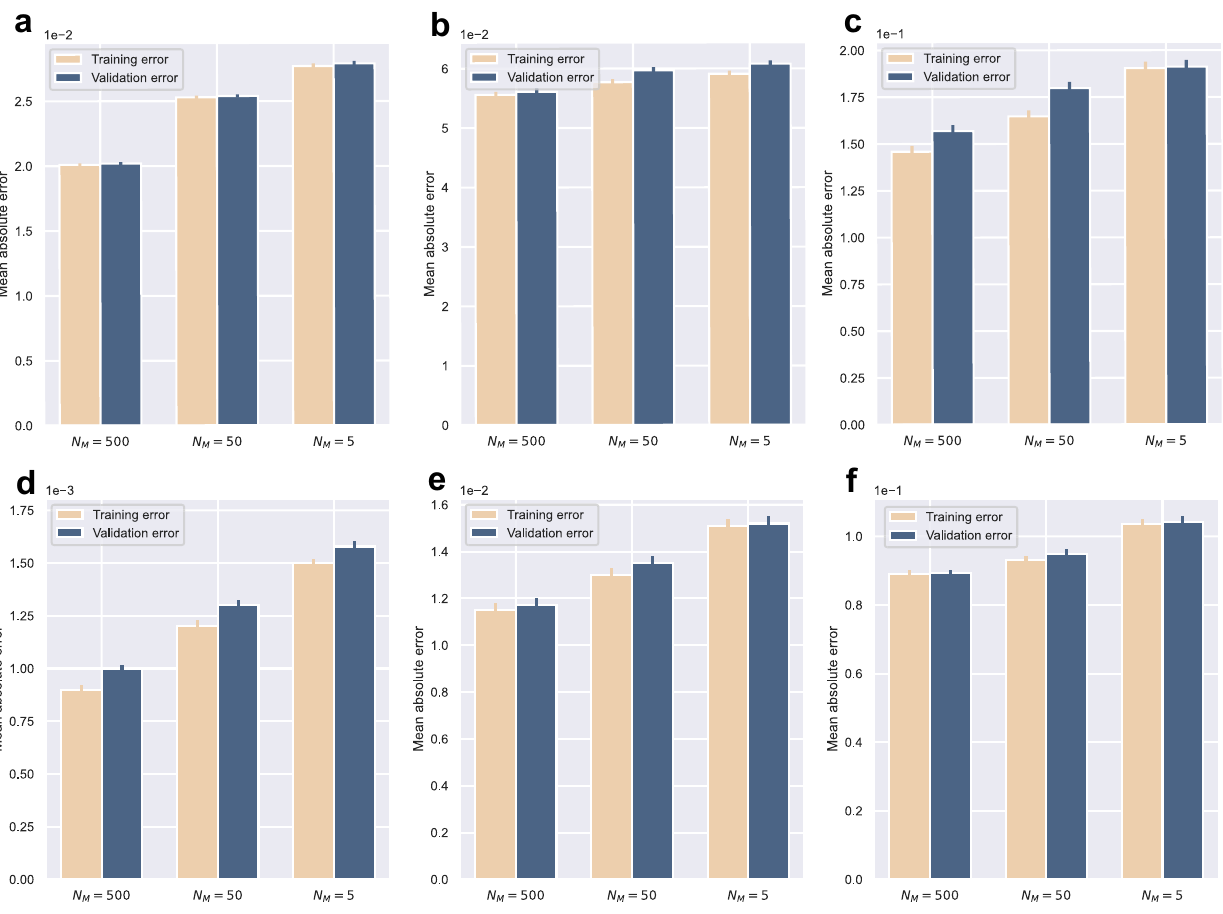
Fig. 6 The mean absolute error (MAE) of different evolution times for estimating the second-order Rényi entropy of half-partition subsystem. a – c are the training and validation MAE with N = 20, J = 1, and evolution times t = {0.5, 1, 3}, respectively. d – f are the training and validation MAE with N = 30, J ~ U (0, 1], and evolution times t = {0.5, 1, 3}, respectively. The error bar denotes the standard variance of repeated runs with different